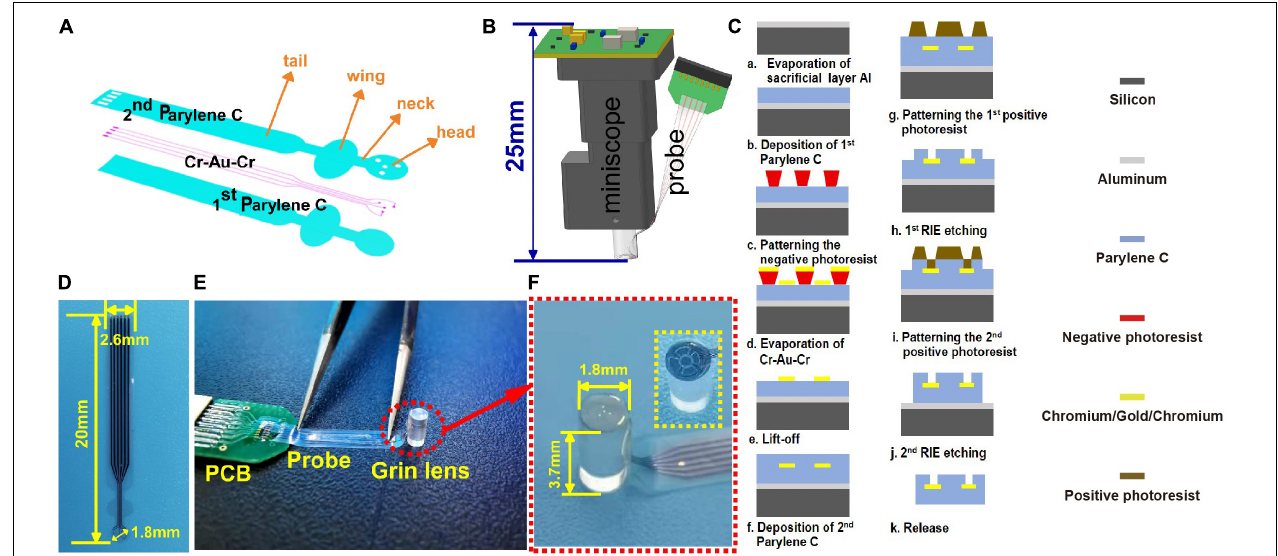
FIGURE 1 | (A) The design of the probe; (B) the concept diagram of the modified system for simultaneously observing Ca 2 + and cortical electrophysiology; (C) the microfabrication process of the electrode probe from the cross-sectional view; (D) the fabricated probe; (E) the assembled probe and GRIN lens; and (F) the zoom-in view of the imaging and recording regions of the electrode probe as red dotted circles in panel (E) . The inset circled by a dotted box is another type of probe designed in the experiment for imaging